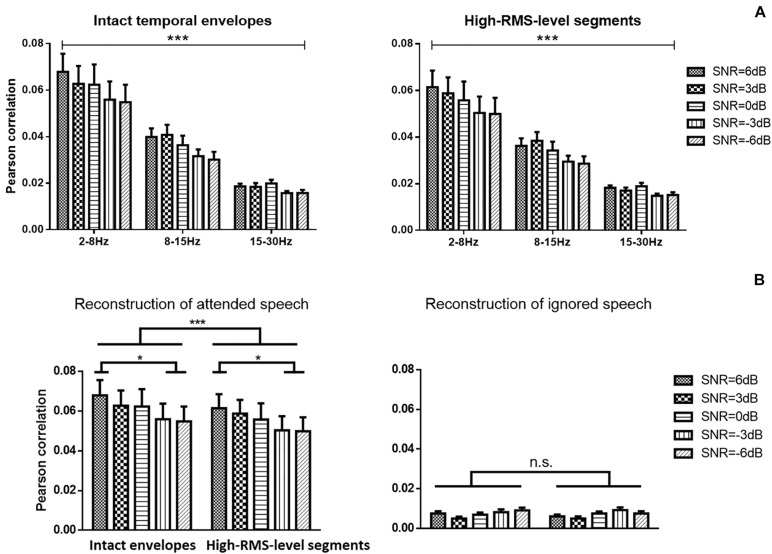
(A) Speech envelope prediction correlations under various signal-to-noise ratio (SNR) conditions with the band-pass filter at 2–8, 8–15, and 15–30 Hz. Error bars display mean ± standard deviation. (B) Speech envelope prediction correlations under various signal-to-noise ratio (SNR) conditions for attended and ignored streams at the 2–8 Hz frequency band. *P < 0.05, ***P < 0.001 (prediction differences). n.s., no significant difference (analysis of variance).